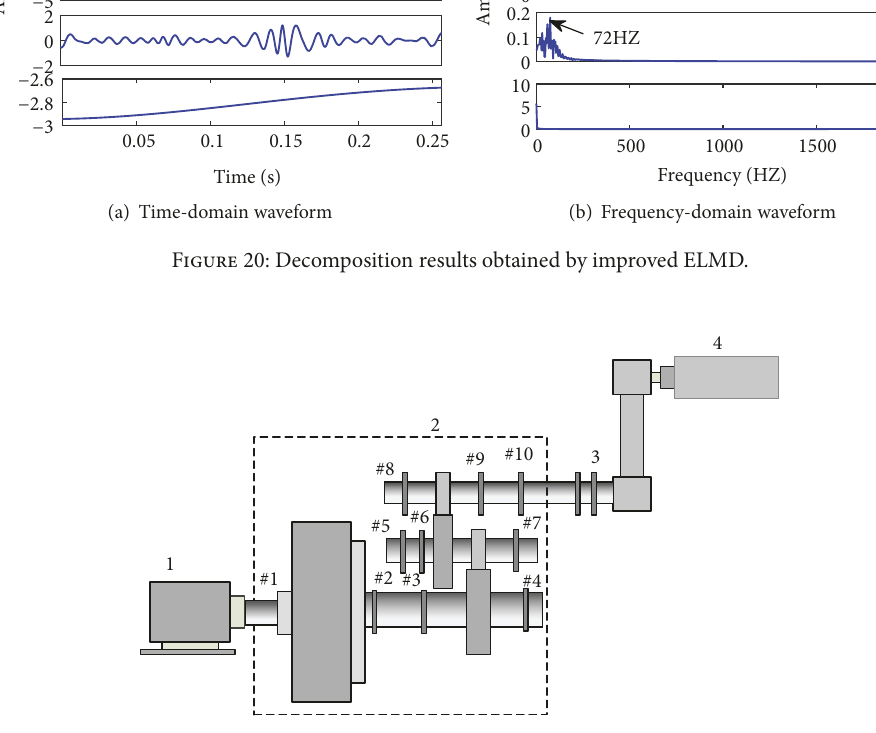
Figure 21: Schematic of wind turbine gearbox test